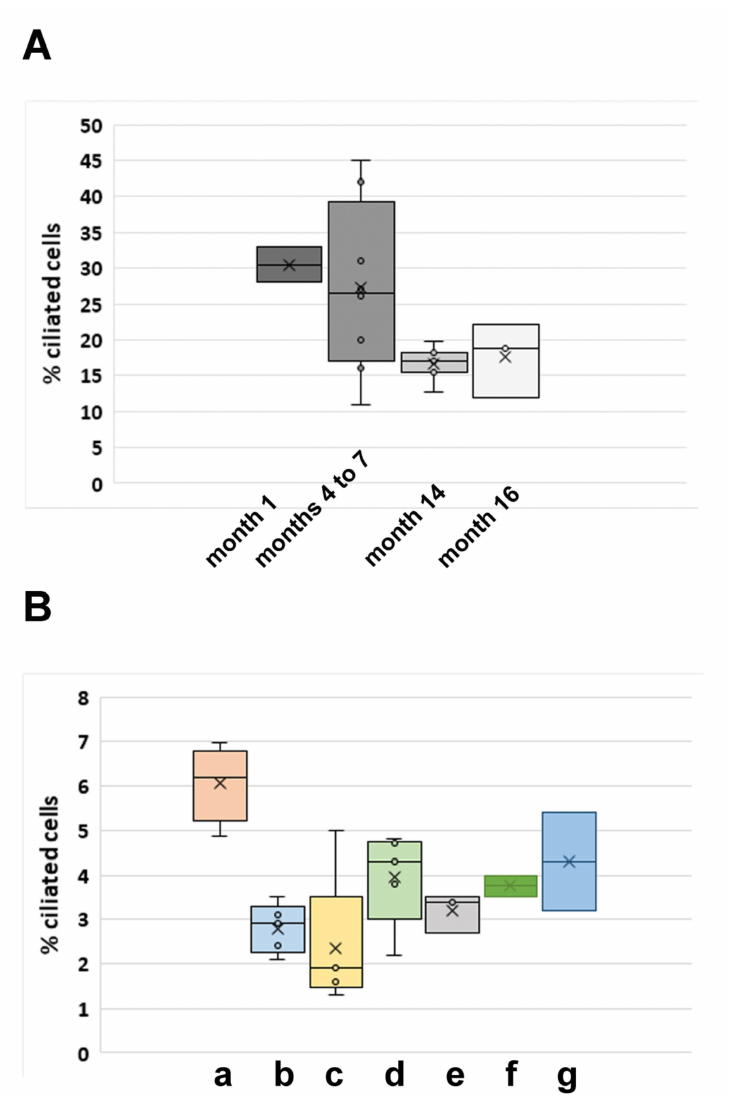
Figure 3. Decrease of acetylated cilia by long-term cultivation of NIH3T3 cells. ( A ) The NIH3T3 sub-cell line charge III was cultivated over a period of 16 months and routinely inspected for the presence of acetylated primary cilia. Cells were cultivated in standard medium (DMEM+10% FCS) at a density of 1 × 10 5 cells per 6-well plate for 1 day, then immune-decorated for acetylated tubulin, and had their primary cilia counted. ( B ) Decrease of ciliation from ~6% to ~3% after approximately two years of intermittent cultivation of NIH3T3 sub-cell line F/F-con. Cells were cultivated in the standard medium at a density of 1.2–4.8 × 10 5 cells per 6-well plate at the beginning of the experiment (a, n = 2037, four biological replicates), and later on at a density of 2.5 × 10 5 cells per 6-well plate (b–g). Cells were either cultivated in standard medium for 24 h followed by immune-decoration (a, b, d, f, g) or were first grown in standard medium for 24 h followed by 48 h in serum starvation medium [DMEM + 0.5% FCS] before processing for immune decoration of acetylated tubulin (c, e). Inhibition of HDAC6 by TSA (d, e), of SIRT2 by nicotinamide (f), and of both HDAC6 and SIRT2 (g). (b: five biological replicates, n = 2463; c: five biological replicates, n = 2610; d: five biological replicates, n = 2522; e: three biological replicates, n = 1349; f: two biological replicates, n = 987; g: two biological replicates, n = 998). a: start of the experiment, standard medium (nm), b–g: after ~ two years of intermittent cultivation, b: nm, c: serum starvation medium (ssm), d: nm + TSA, e: ssm + TSA, f: nm + nicotinamide, g: nm + TSA + nicotinamide. The median is represented as a line, the average as a cross. Individual values are shown as a